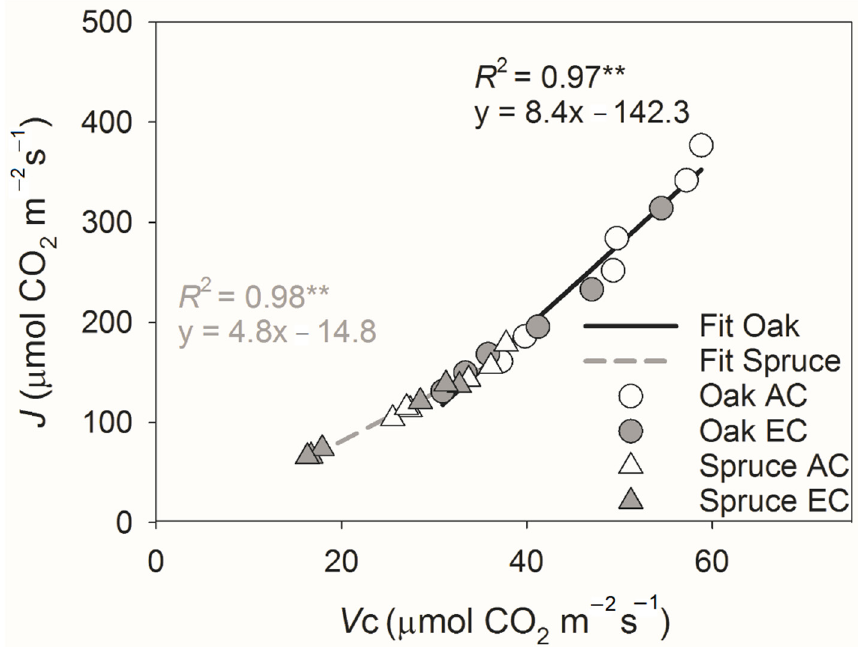
Figure 6. Relationship between in vivo rates of Rubisco carboxylation ( V C ) and electron transport ( J ) at 25 ◦ C in sessile oak and Norway spruce. The solid and dashed lines represent the linear regressions (Fit) of oak and spruce data, respectively. Coefficient of determination ( R 2 ) and significance level (**; p < 0.01) are